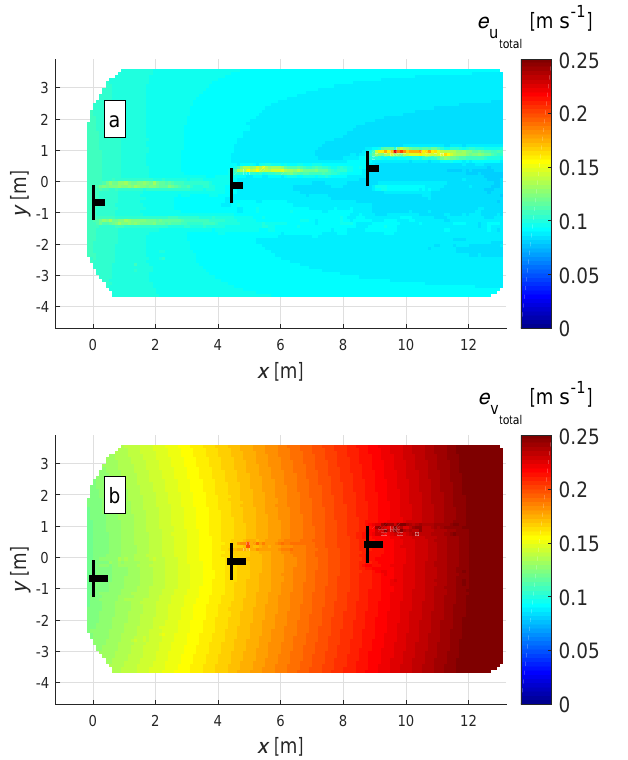
Figure 26. Dual-Doppler uncertainty on the evaluated u (a) and v (b) components including wake gradient